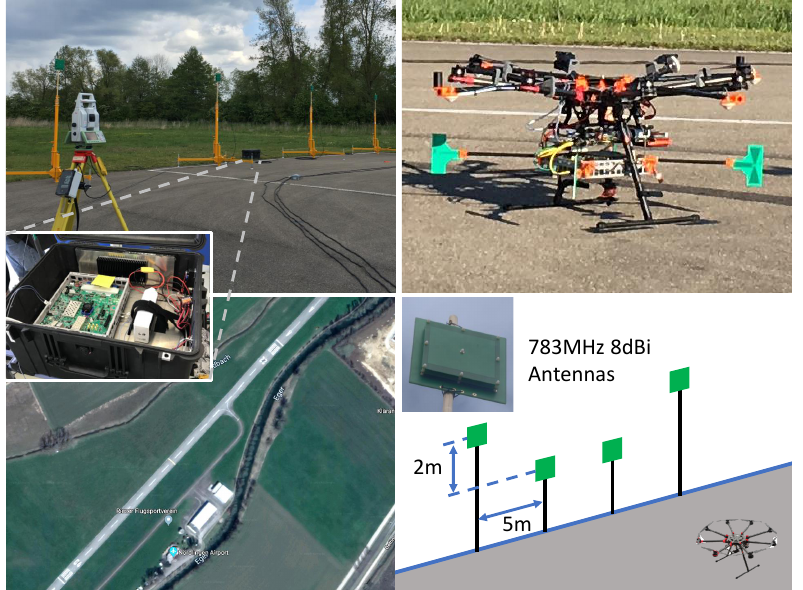
Figure 20. Flight test experimental configuration. One user consists of 4 patch antennas mounted on telescoping mounts ( top left ) and the hardware enclosed in a ruggedized case ( left ). The second user is mounted to a DJI S1000+ UAV for flight testing ( top right ). These experiments were performed on a runway about 700 m long ( bottom left ) using a simple antenna geometry ( bottom right